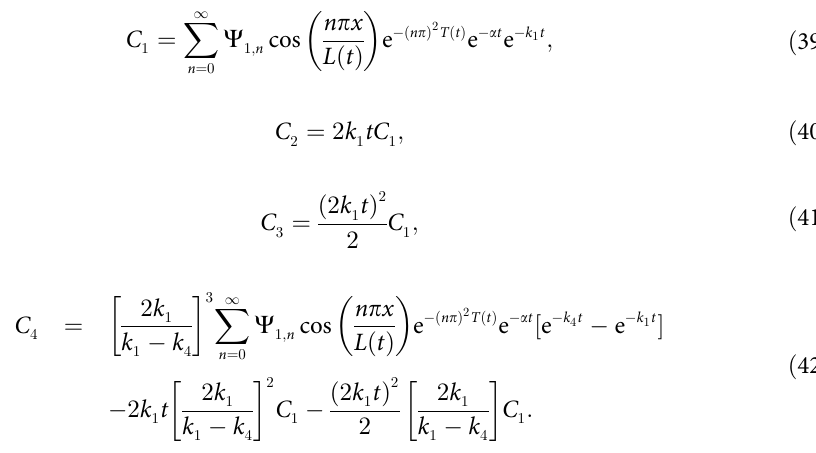
PLOS ONE | DOI:10.1371/journal.pone.0138894 September 25,